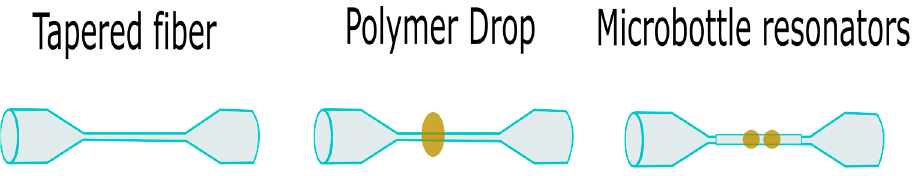
Figure 4. Self-assembled MBR.